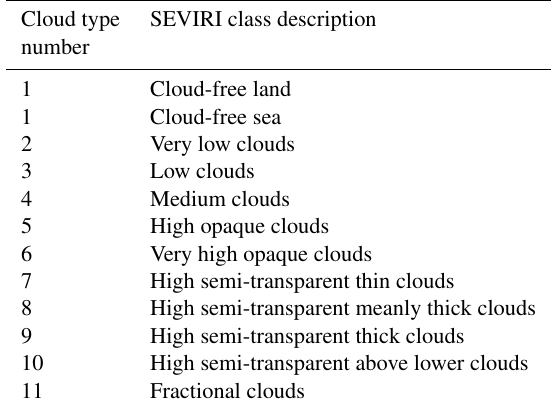
Table 2. Cloud classification from SEVIRI (Derrien and Le Gléau,